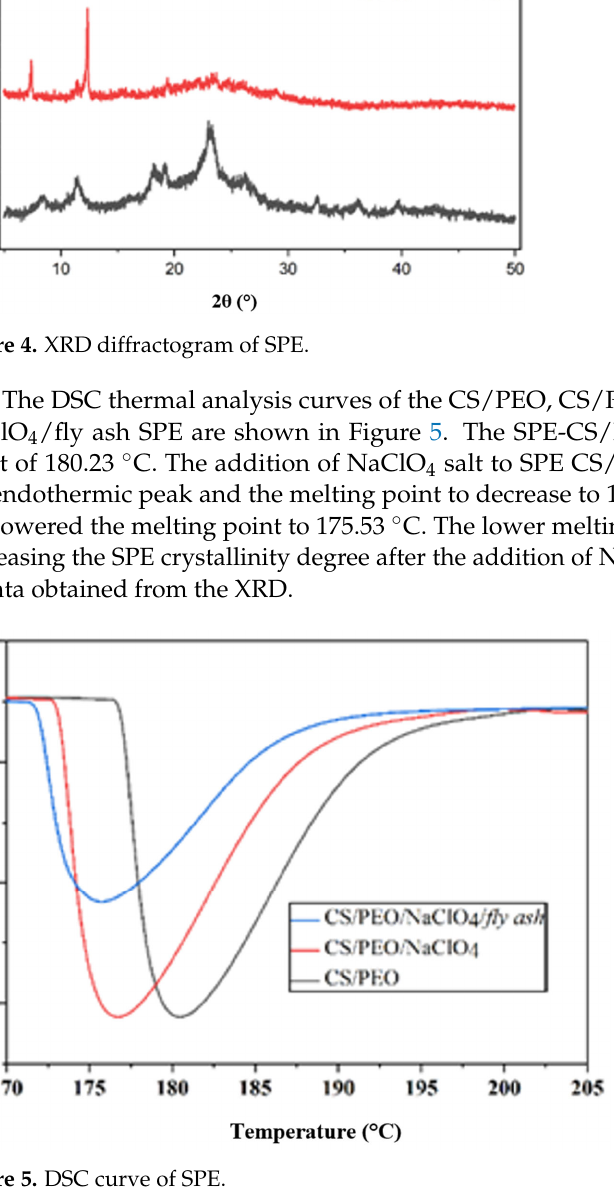
Figure 5. DSC curve of SPE.